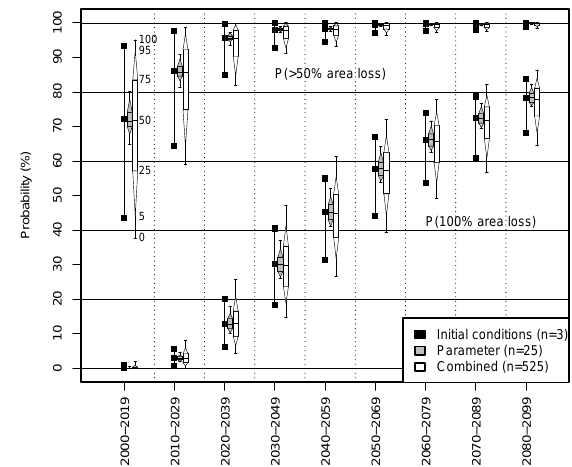
Fig. 7. Confidence intervals on estimated probabilities of half (up- per boxplots) and all (lower boxplots) palsa areas becoming unsuit- able for 20yr periods during the 21st century relative to 1961–1990 for initial conditions (black points), parameter uncertainty (gray boxplots) and a combination of the two for the ensemble of GAM (white boxplots). Initial condition uncertainty was calculated as GAM ensemble averages of 25 models each calibrated for different baseline periods (1951–1980, 1961–1990, 1971–2000); parameter uncertainty is shown for models calibrated for the period 1961– 1990; the combined confidence intervals were calculated by sam- pling between the baseline periods (see Appendix B). Probabilities were estimated by evaluating the impact response surface for the Grand Ensemble ( n =10000) with SRES A1B forcing. Boxplots show lower quartile, median and upper quartile; triangle peaks show the 5th and 95th percentiles (defining 90% confidence intervals); whiskers delimit the smallest and largest 31